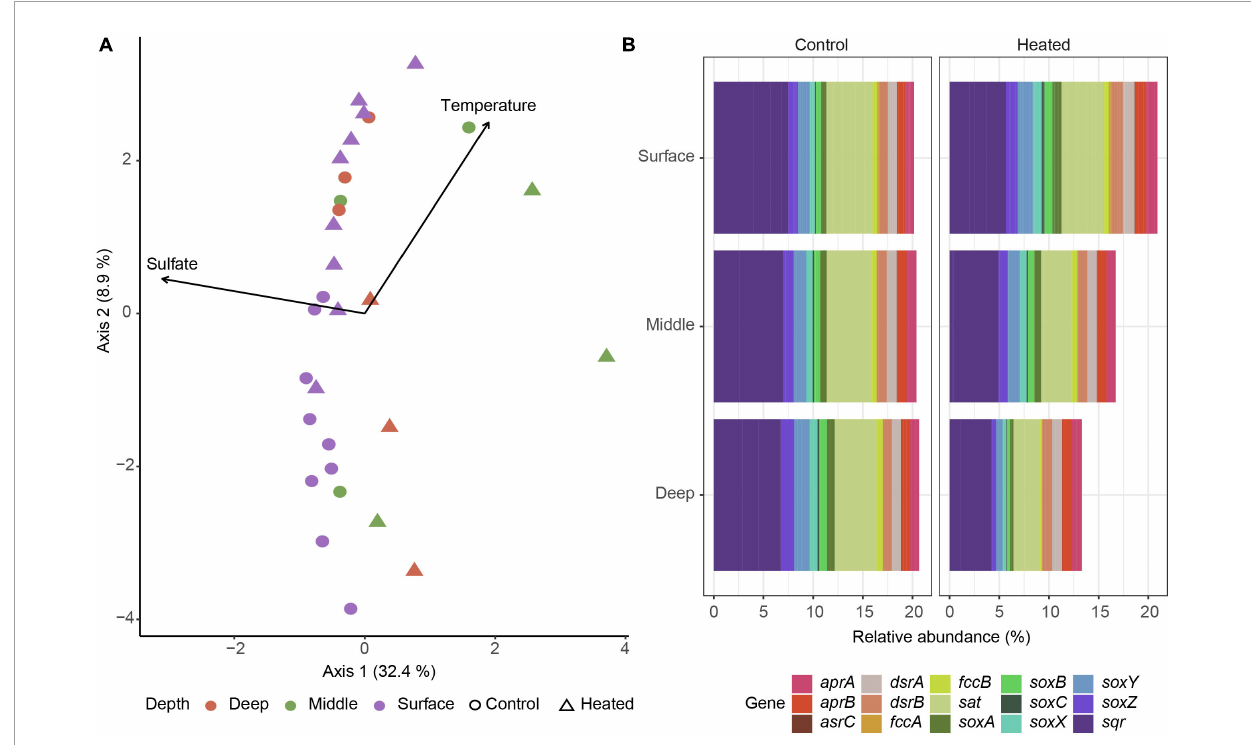
FIGURE5 16S rRNA gene ASV based prediction of sulfur cycling related functional abundances. Bray–Curtis based db-RDA of predicted functional genes related with sulfur cycling according to KEGG identifiers for the heated (triangle) and control (circle) bays at surface (purple), middle (green), and deep (red) sediment depths with the environmental parameters of sulfate and temperature (A) along with plots of relative abundances of selected dissimilatory sulfate reduction and sulfide oxidation genes in the control (left) and heated (right) bay (B)